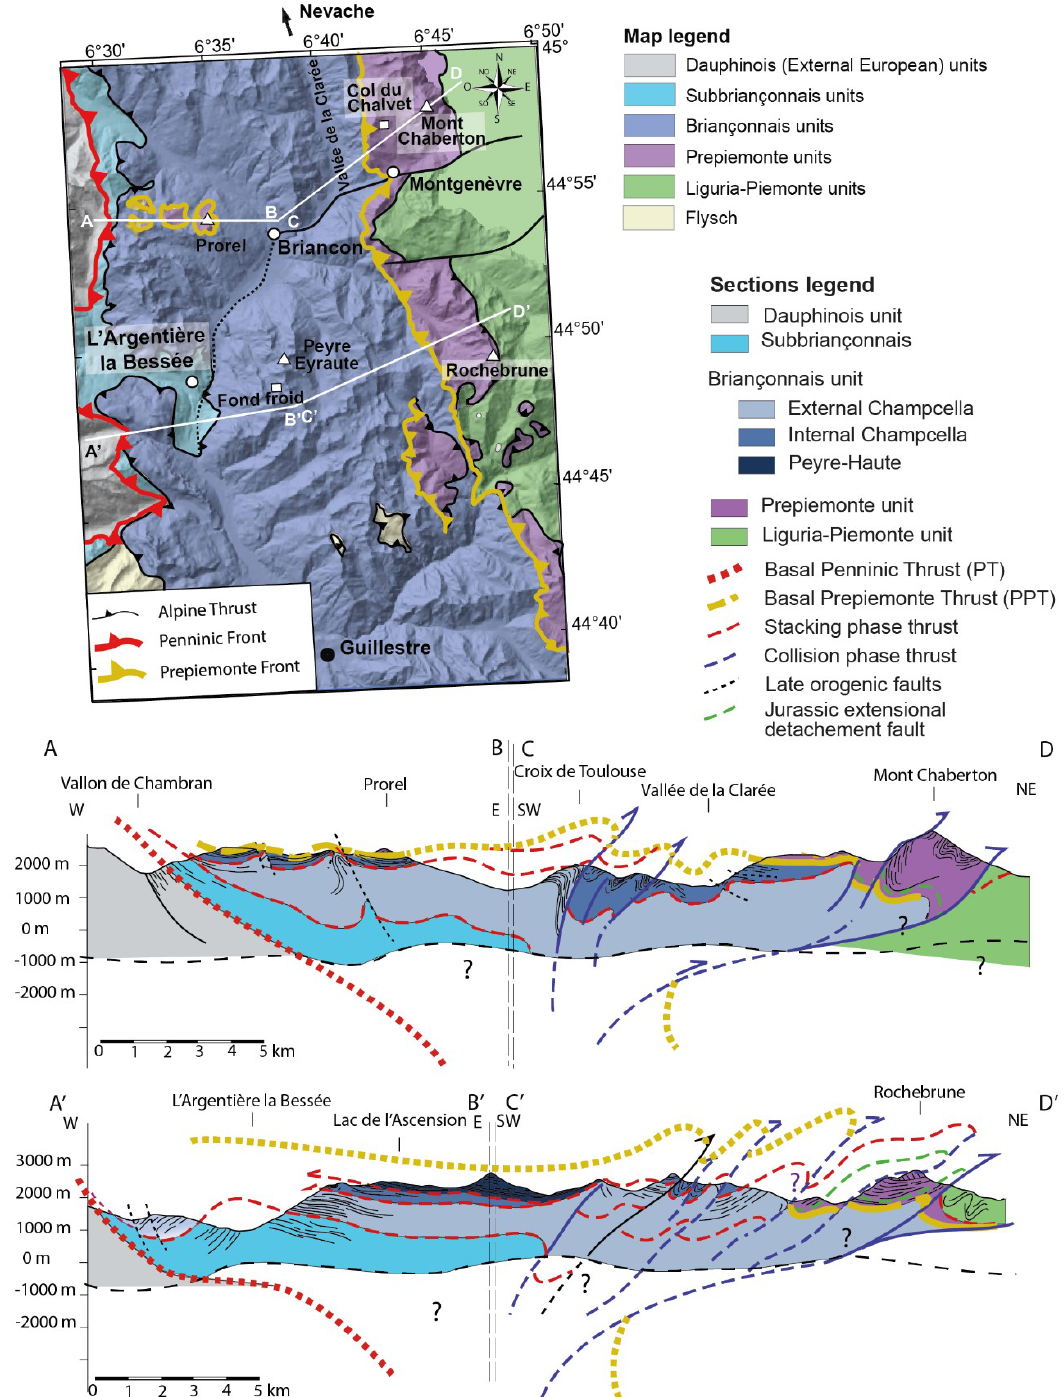
Figure 5. Tectonic map and geological sections across the study area. Five main Alpine units separated by major Alpine thrusts can be distinguished, namely the Dauphinois, the Subbriançonnais, the Briançonnais, the Prepiemonte and the Piemonte units. The Basal Penninic Thrust (PT; red line) between the Dauphinois and the Briançonnais s. str. units and the Basal Prepiemonte Thrust (PPT; yellow line) between the Briançonnais s. str. and the Prepiemonte units are both major rift- and orogenic structures (see text for details and discussion).